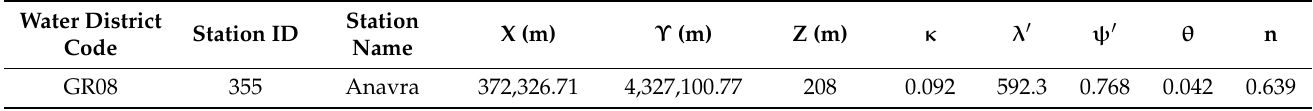
Table 2. Parameters used in the IDF curve equation [36], regarding the Anavra station and a 1000-year return